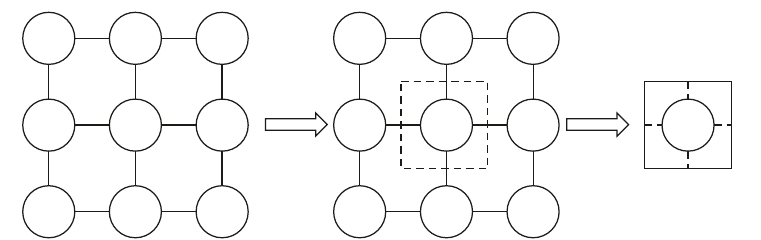
Figure 2: Schematic diagram of the TH/ crud modules transforming: volume averaged COBRA-IV channel information for crud model